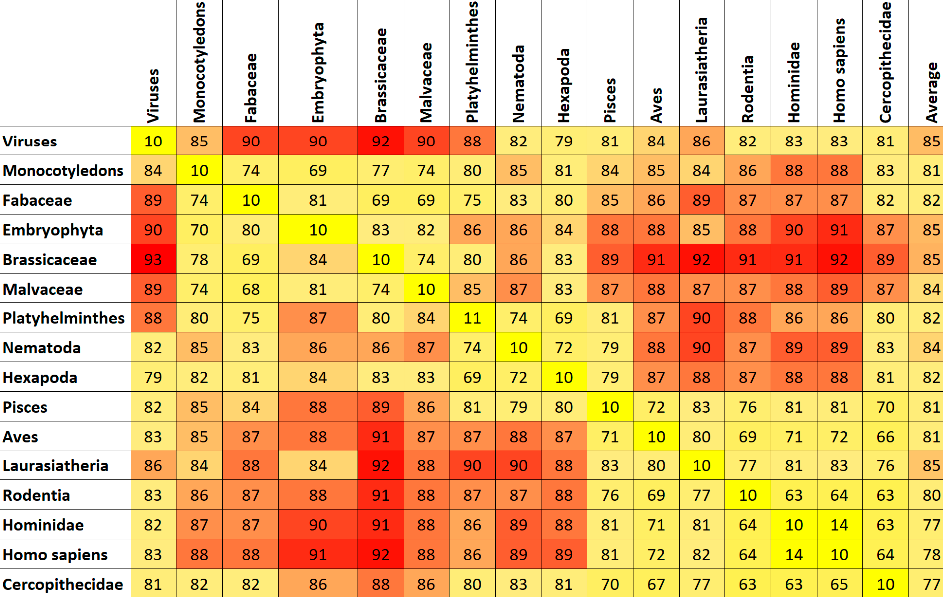
Figure 3. Results in the figure stem from k-mer features only. Average accuracy for 100-fold Monte Carlo cross-validation using a random forest classifier and a split of 80% training and 20% testing. Yellow shades indicate lower accuracy, while red shades show higher average classification accuracy.